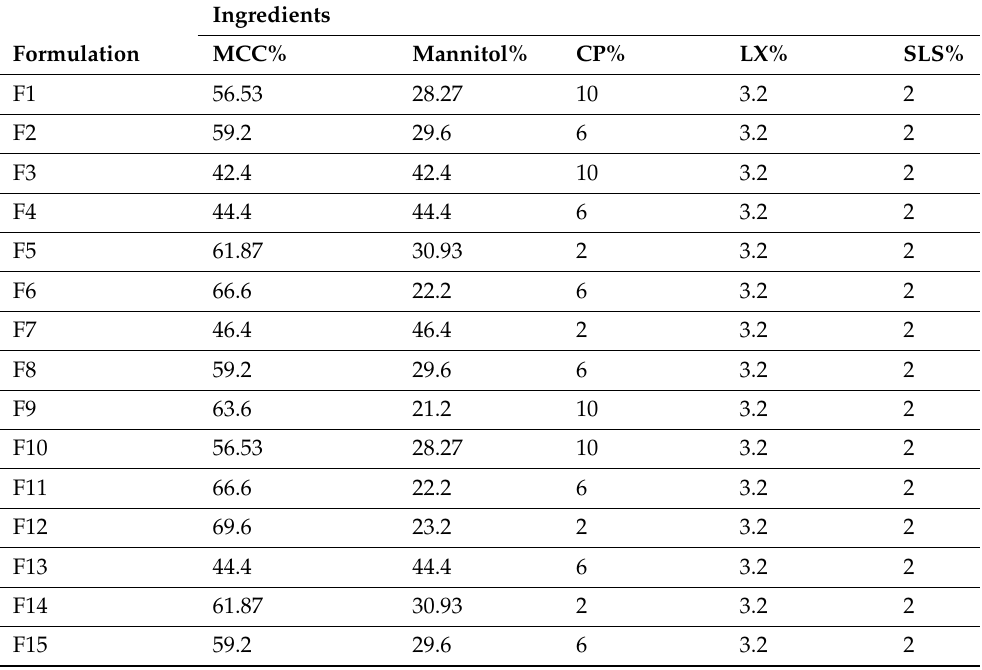
Table 10. Composition of different formulae of Lornoxicam